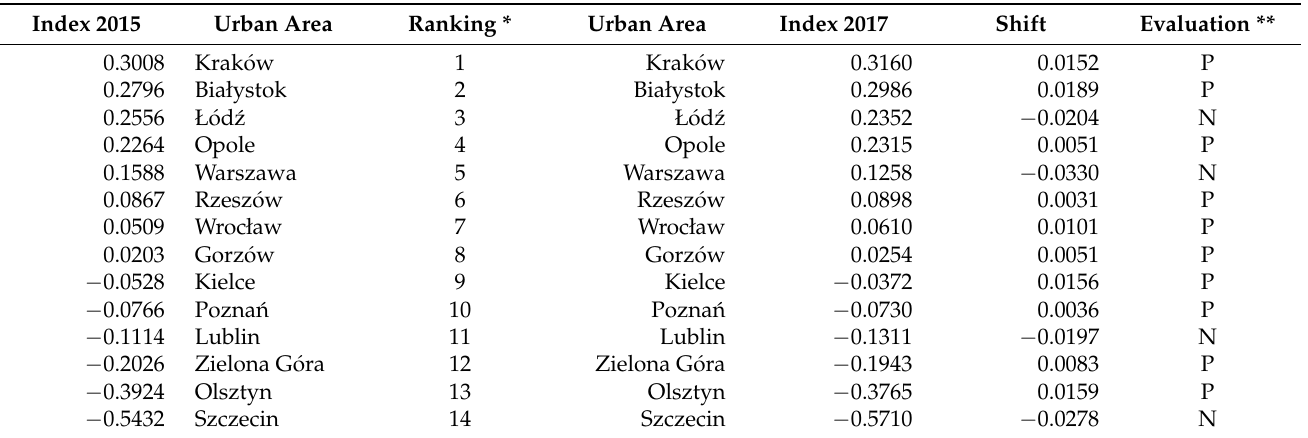
Table 8. Ranking of urban areas in terms of urban